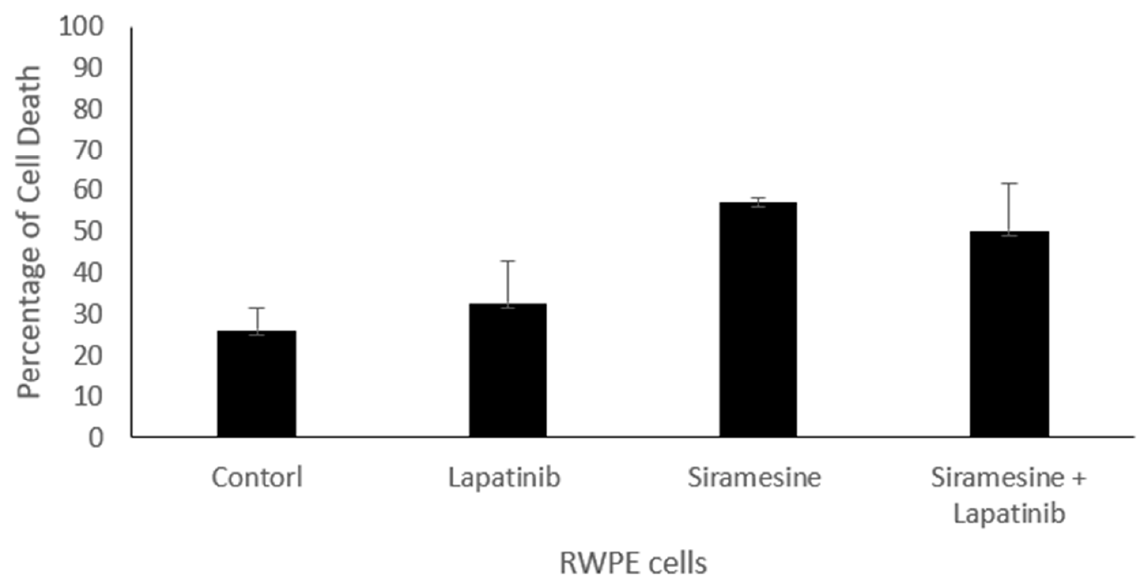
Figure 9. Siramesine and lapatinib treatment in non-transformed prostate epithelial cells RWPE. RWPE cells were treated with siramesine (10 mM) and/or lapatinib (0.5 mM) for 24 h. Control represent cells treat with DMSO. Amount of cell death was determined by Trypan blue exclusion assay. The error bars represent standard error and is the determine from three independent experiments.